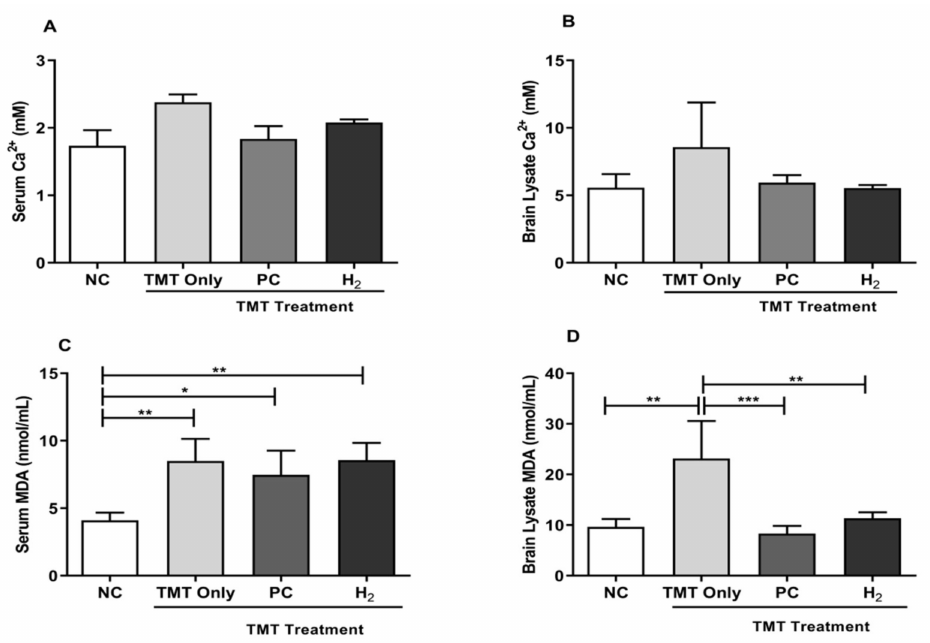
Figure 5. Effects of H 2 gas inhalation treatment on Ca 2+ and MDA levels in TMT-induced C57BL/6 mice after four weeks. ( A ) Serum Ca 2+ level, ( B ) Brain lysate Ca 2+ level, ( C ) Serum MDA level, ( D ) Brain lysate MDA level. Data are shown as the mean ± SEM for n = 4 mice. Significant differences were analyzed with ANOVA and Tukey’s test. * p < 0.05, ** p < 0.01, *** p <